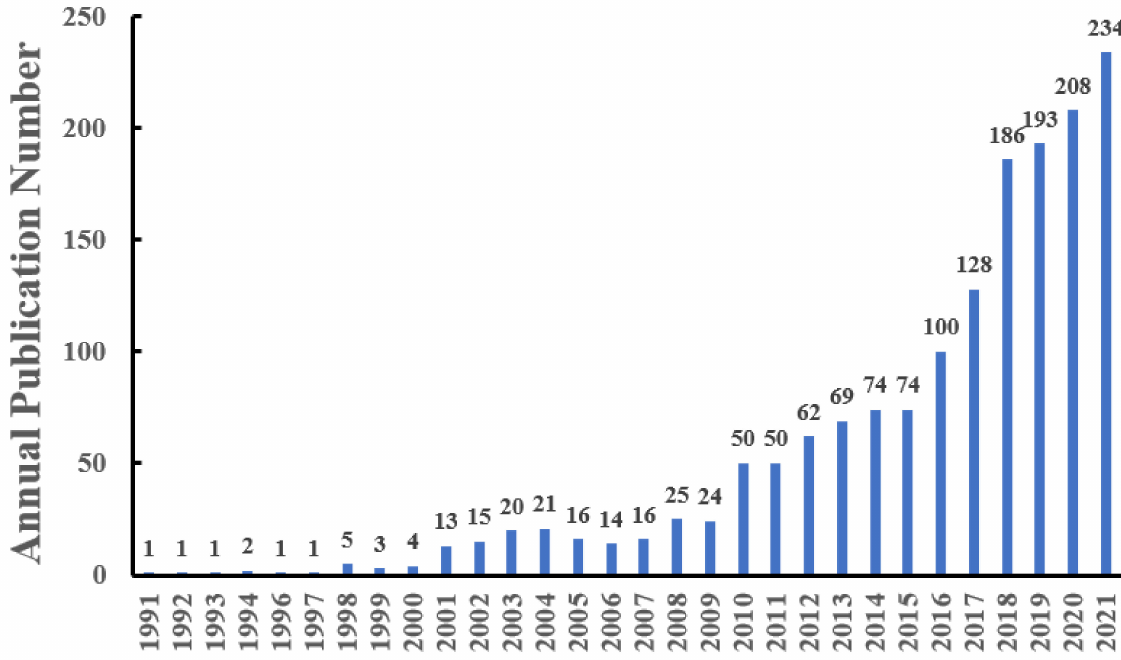
Figure 2. Annual publication number between 1991 and